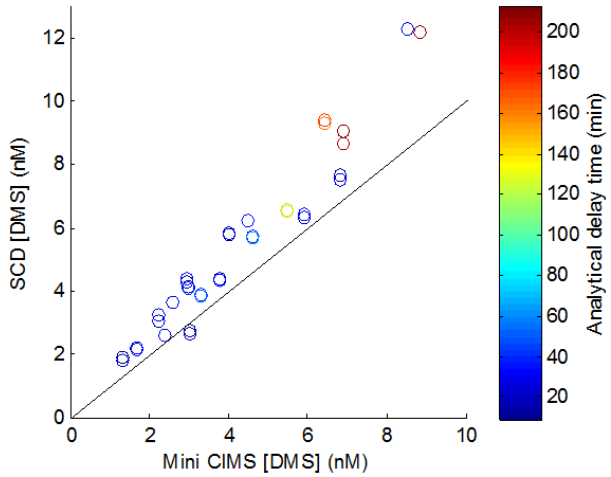
Figure 3. Comparison between [DMS] measured using the miniCIMS and SCD methods. The colour bar indicates the time elapsed between sample collection and analysis on the SCD. MiniCIMS analysis was near real time, so data are averaged over a 1h period surrounding the SCD sample collection time. The black solid line is 1 :